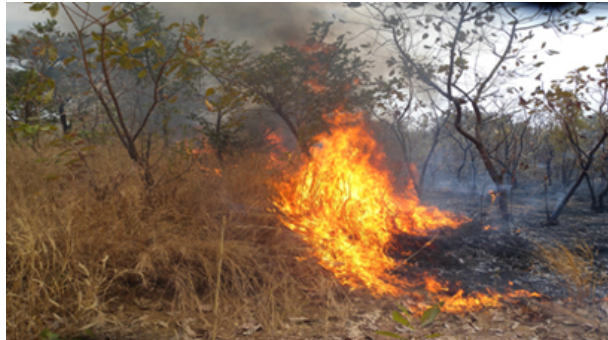
Figure 7. A head fire extending from a bed of dry grasses into the green leaves in the tree canopy, Tabou Village, Mali (Photo by Paul